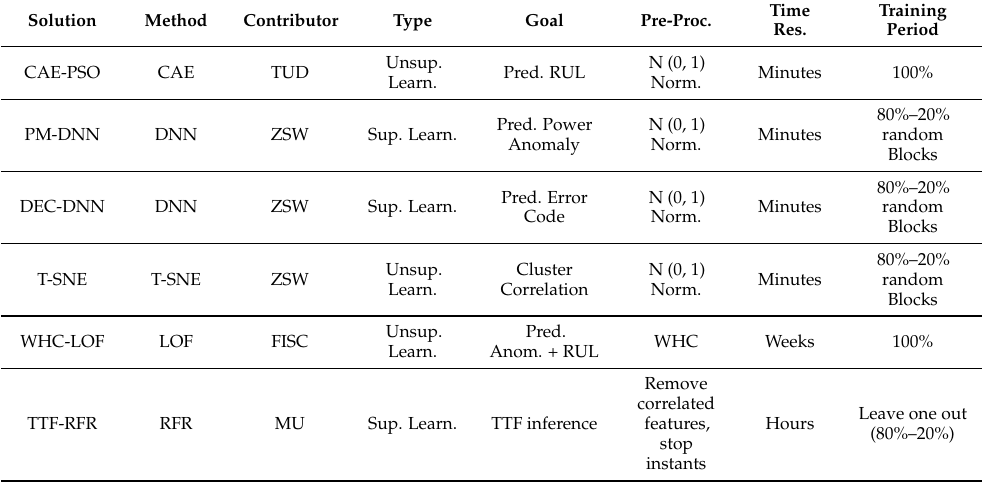
Table 1. Summary of all the submitted solutions.